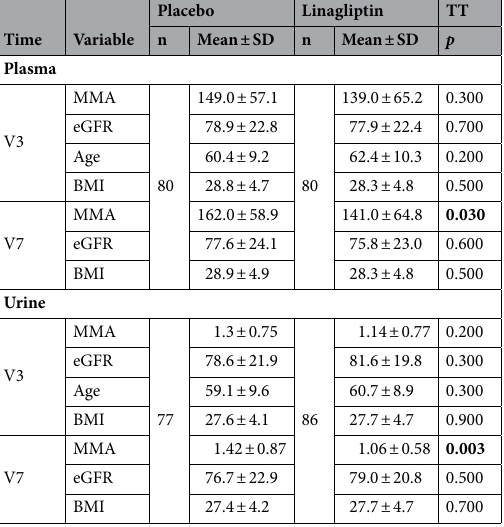
Table 6. Patient characteristics and pMMA and uMMA values of a subset of individuals from the MARLINA trial. Mean and SD of MMA, eGFR, Age and BMI at V3 and V7 at medium MMA levels. eGFR estimated glomerular filtration; MMA methylmalonic acid; SD standard deviation; TT Welch t-test; V3 baseline; V7 end of study. Significant p values (< 0.05) are in bold. BMI, body mass